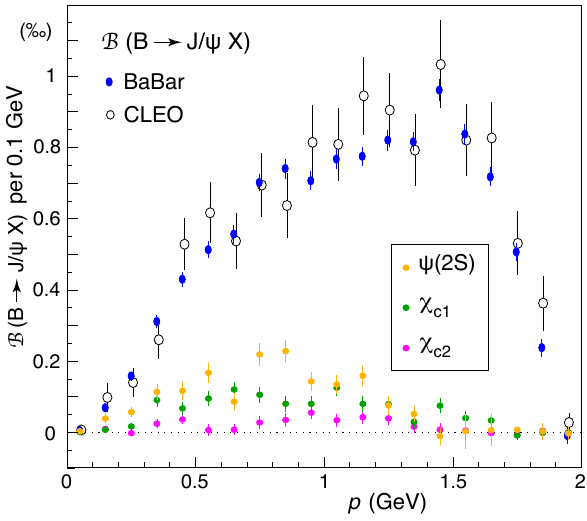
Figure 10 . Laboratory momentum distribution of J /ψ mesons emitted in decays of B mesons that are themselves produced by Υ (4S) decays. Besides the inclusive spectrum, the figure also shows the individual contributions due to the feed-down decays B → χ c 1 , 2 X and B → ψ (2S) X . smaller mother-daughter mass difference leads to a stronger smearing and, hence, a smaller observable